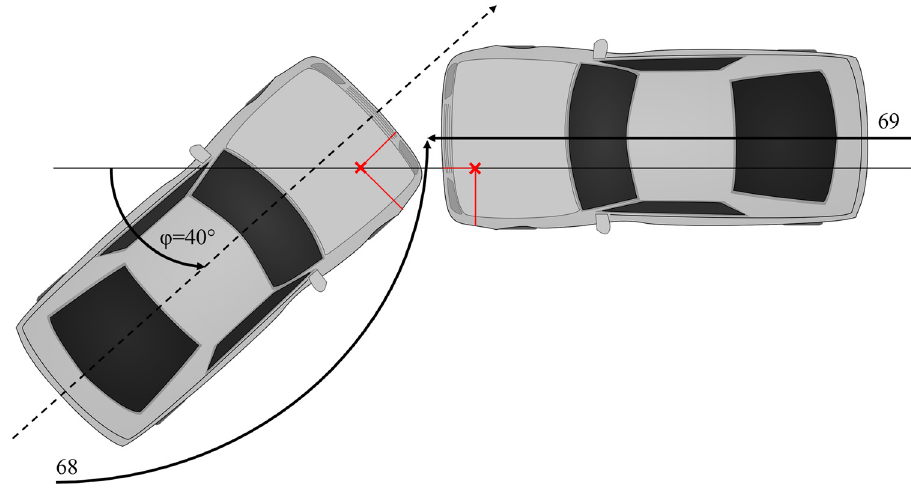
Figure 5: Scenario J – left - turning and crossing ( 68, 69 ) ; result of the accident constellation based on the focal point of